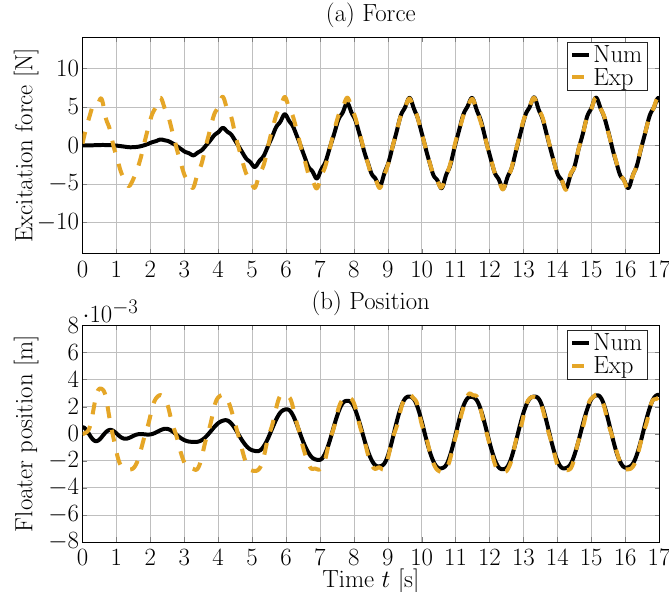
Figure 15. Time trace of the single-frequency (0.54 Hz) excitation force ( a ) and the floater position ( b ).